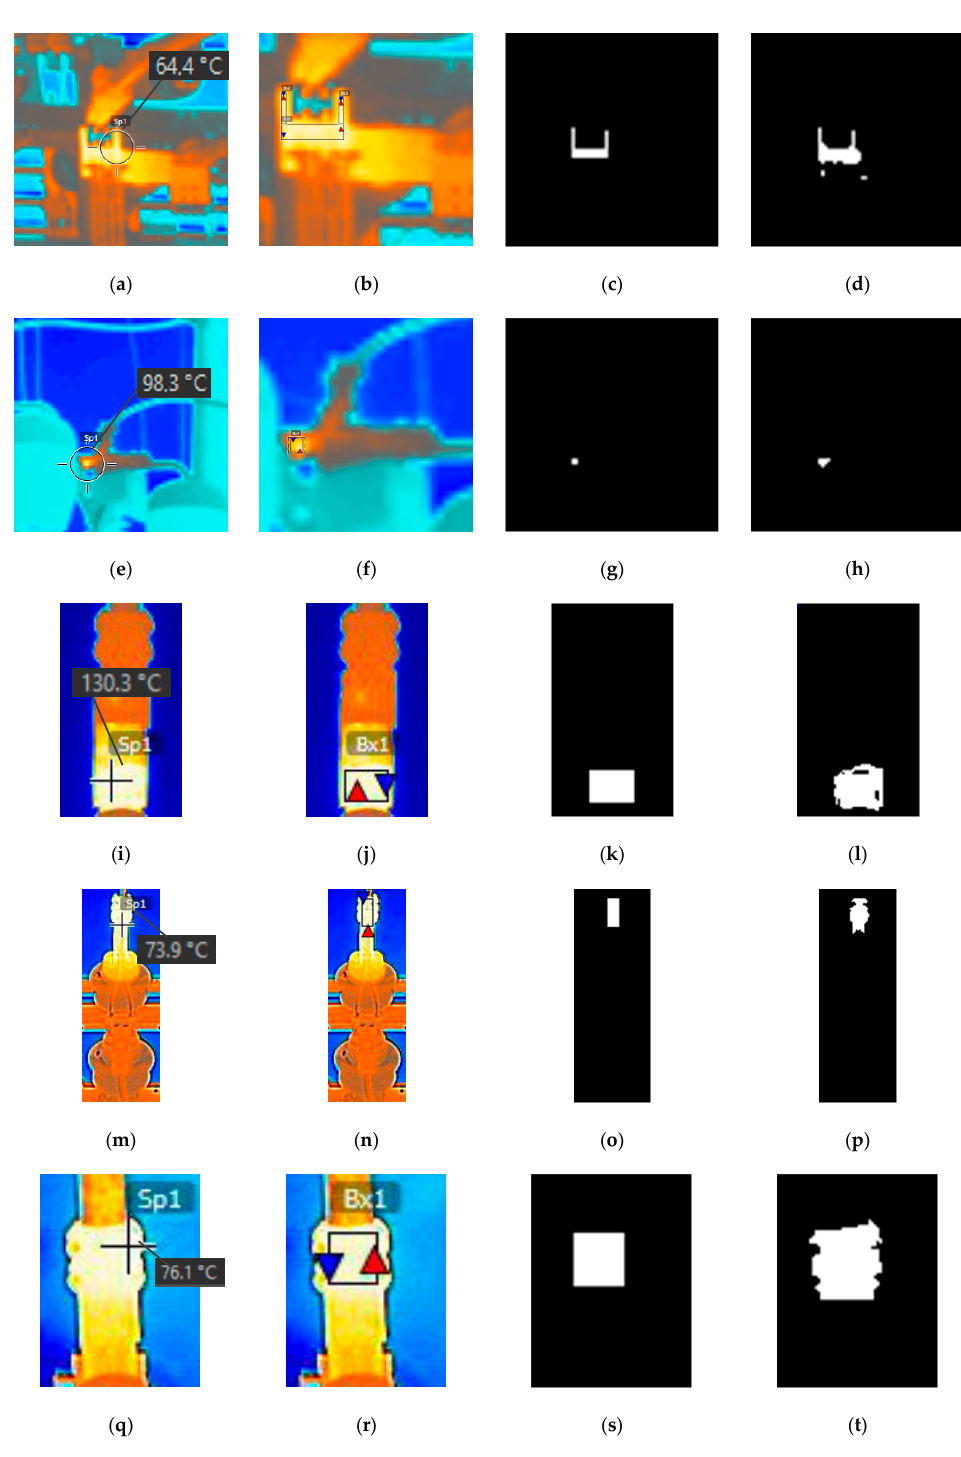
Figure 3. Process for obtaining ground-truth segmentation: ( a , e , i , m , q ) hotspot identified by the thermography technician during inspection; ( b , f , j , n , r ) ROI selected by the technician in FLIR Tools 6.4 ® software; ( c , g , k , o , s ) ROI segmentation selected by the technician performed manually in GIMP ® image editing software—human standard segmentation; ( d , h , l , p , t ) ROI segmentation resulting from the algorithm with the threshold defined by human criteria according to visual perception—improved human standard